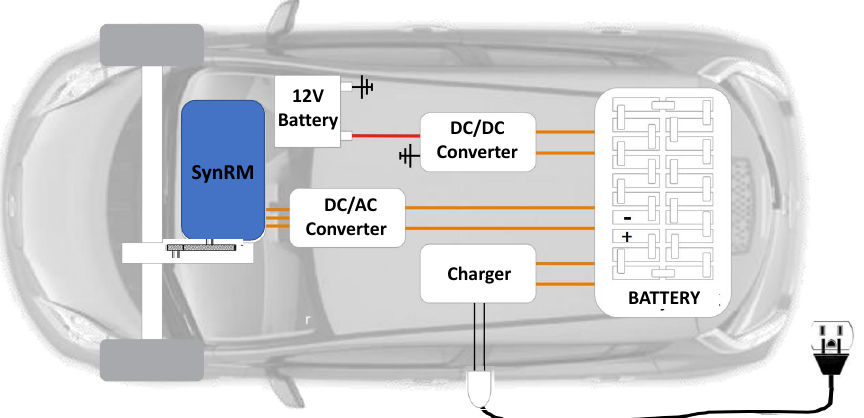
Figure 1. Simplified electric vehicle drivetrain architecture propelled by a